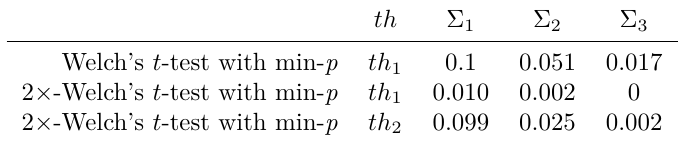
Table 3: Empirical false positive rate ˆ α estimated from 100 , 000 experiments.